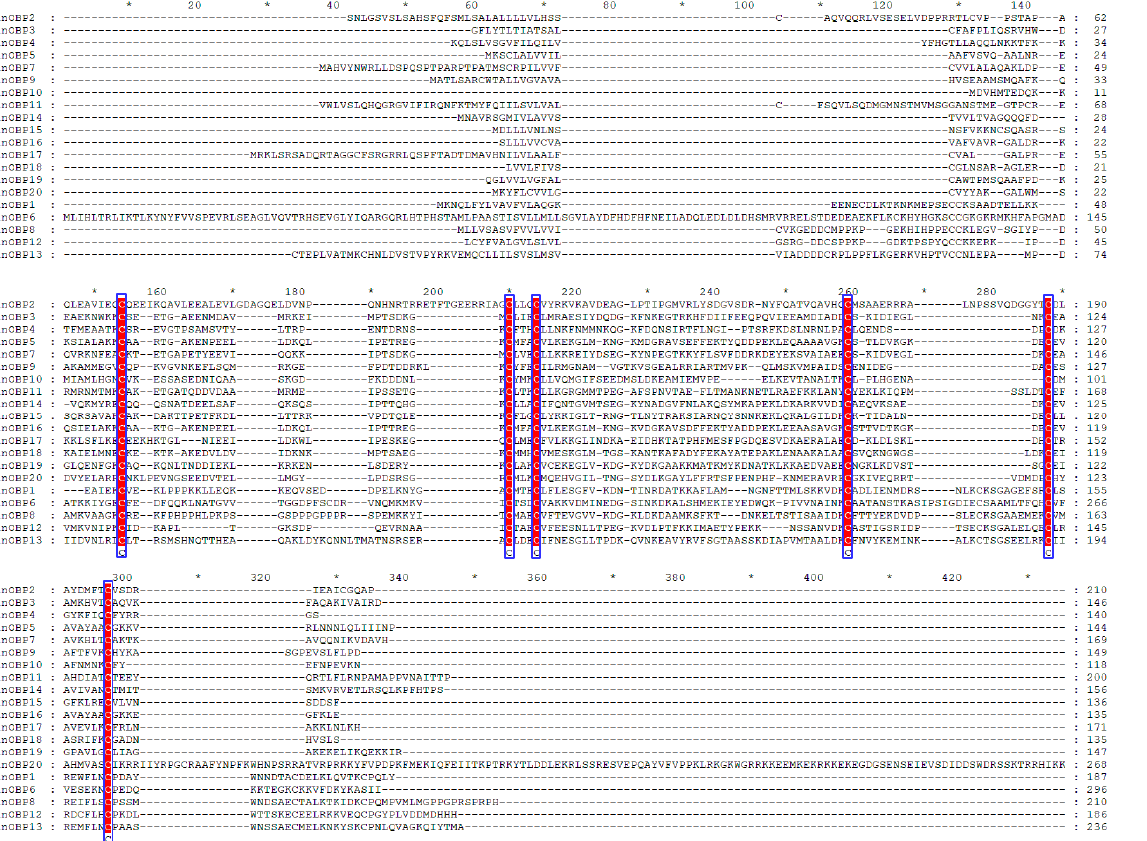
Table 2. List of identified CSP genes of N. cincticeps . Gene ID